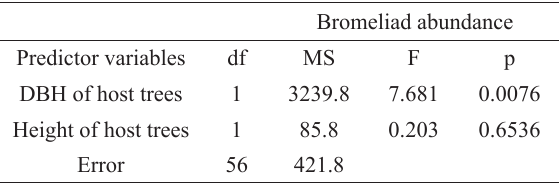
Summary of multiple regression analysis (GLM), testing the relationship between predictor variables (diameter at breast height – DBH - and height of host trees) and dependent variable (abundance of